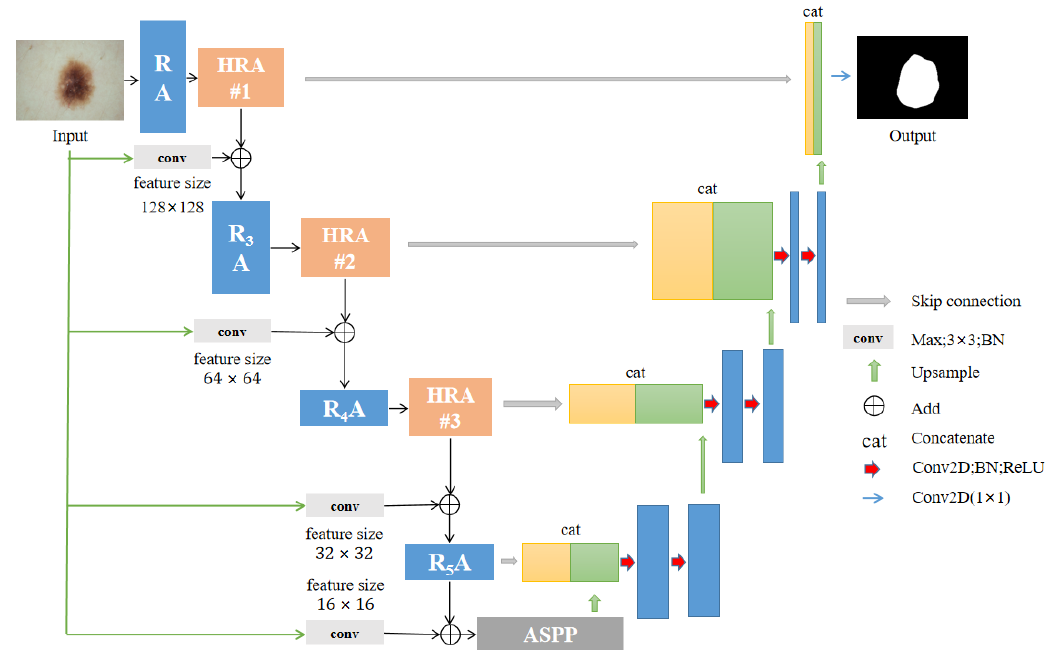
Figure 5. Our proposed MHAU-Net network architecture. RA represents the residual dilated module (as shown in Figure 4). HRA means hybrid residual attention, and it is used three times in total. Transition Phase: ASPP is composed of a 1 × 1 convolution (shown on the far left